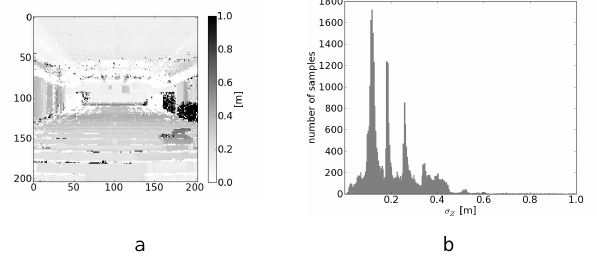
Figure 7. Standard deviation of the depth: a) gray-coded image, b)